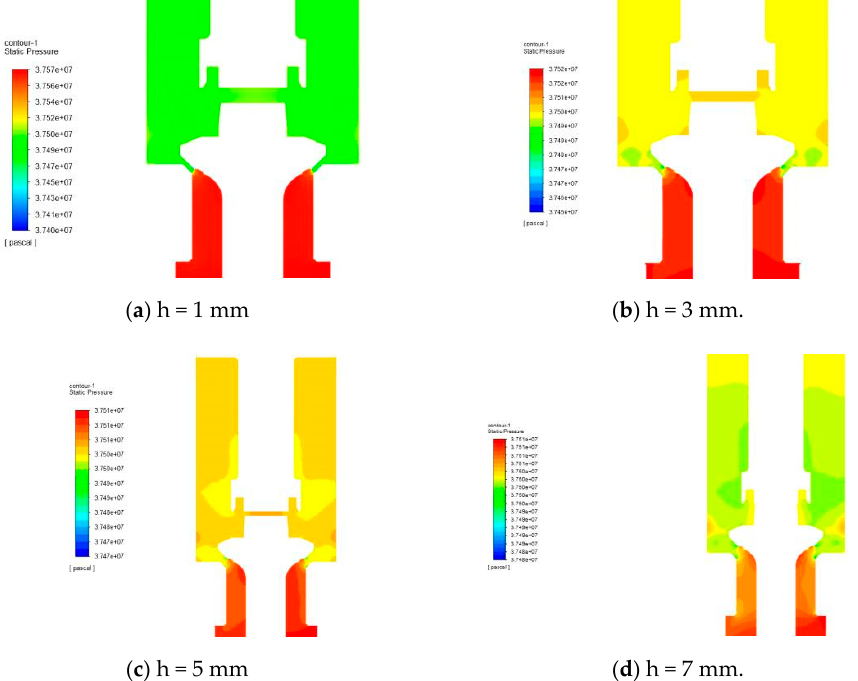
Figure 7. Pressure distributions for the different discharge valve opening lifts.